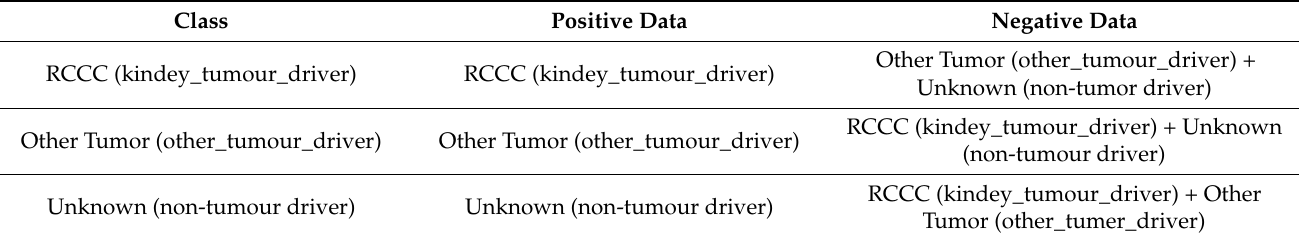
Table 1. Information of Positive and Negative Data for Classes.